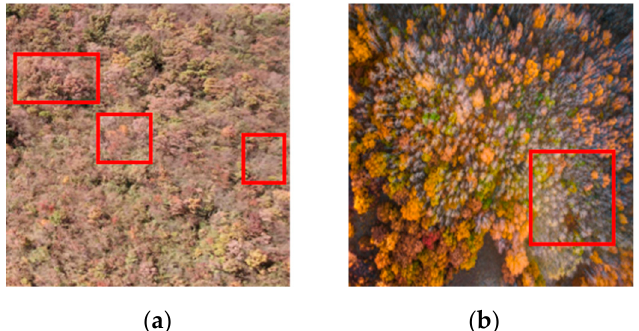
Figure 10. ( a ) The image size is too large, and there is a lot of noise. ( b ) The viewing angle is completely parallel to the ground.